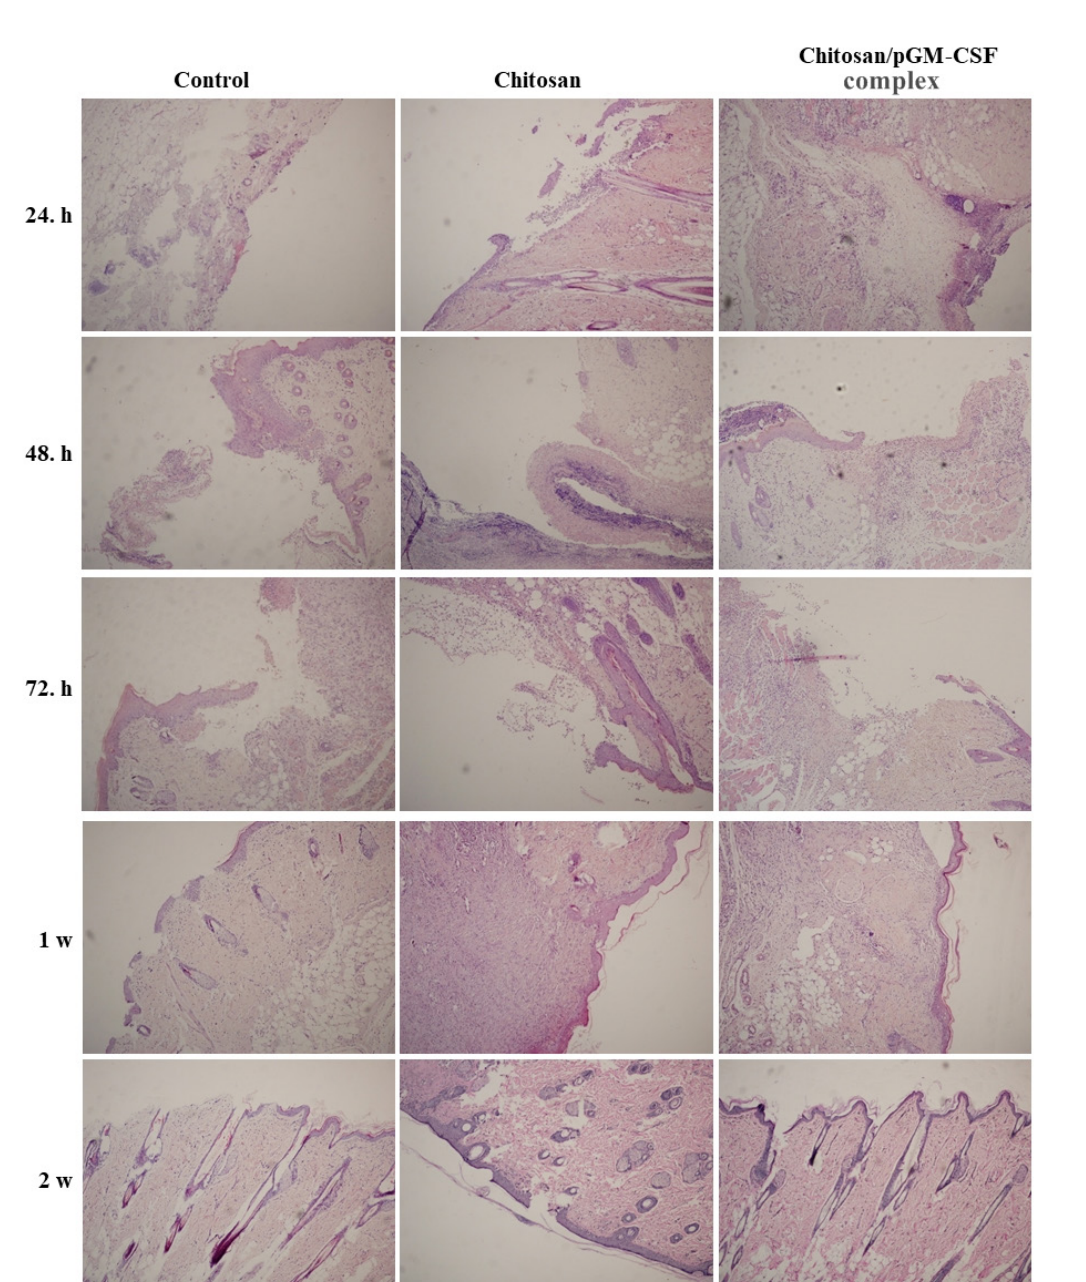
FIGURE 6 - Wound healing in early and late